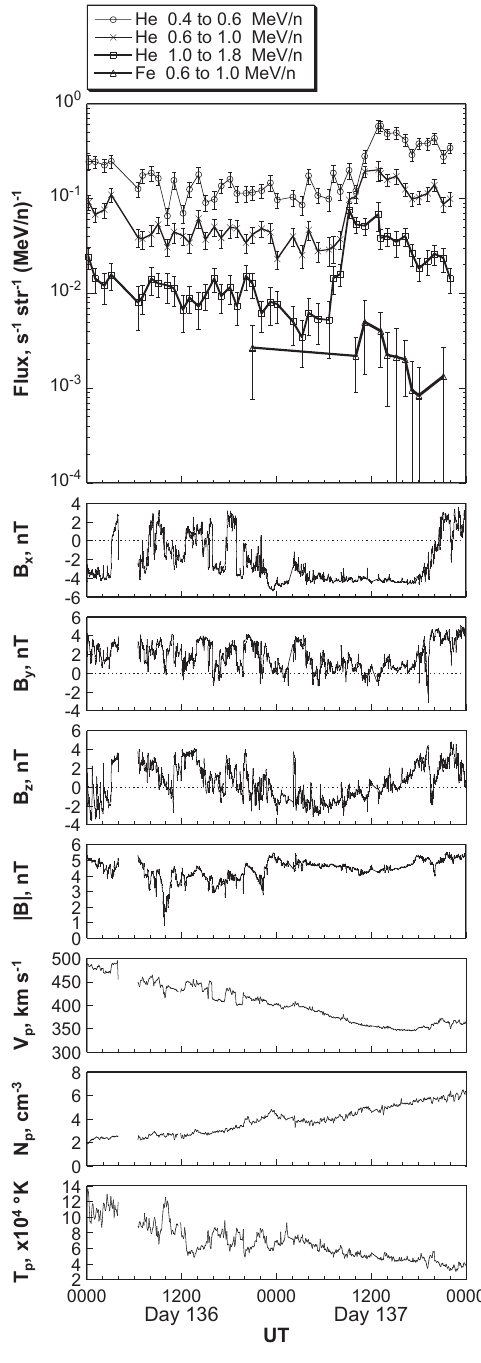
Fig. 2. Fluxes of energetic He ( 3 He+ 4 He) ions, and plasma and magnetic field parameters, plotted for the 17 May 1979 energetic ion